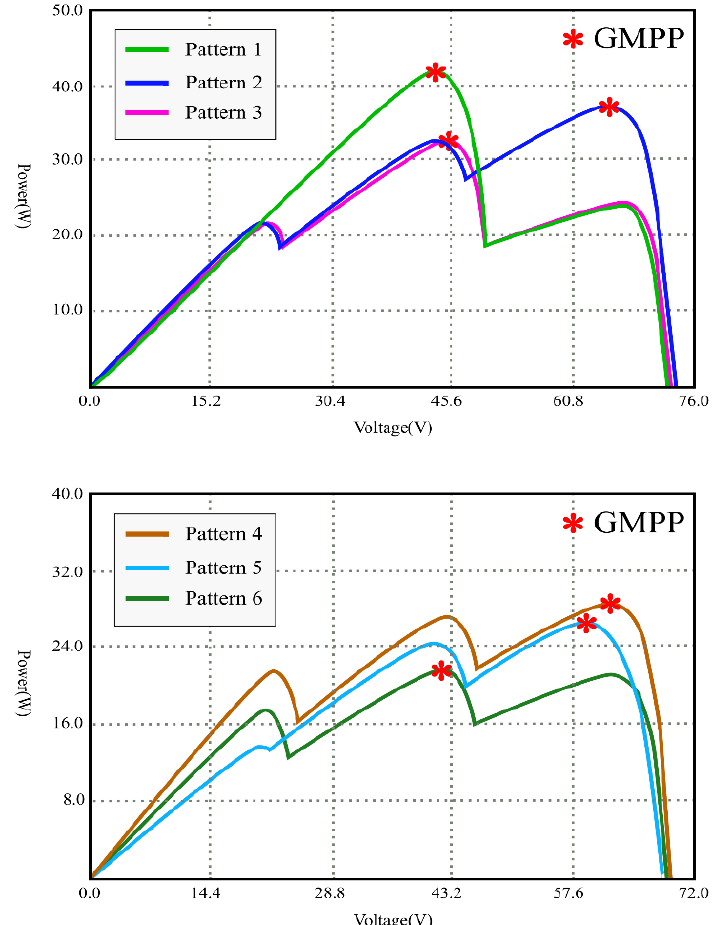
Figure 12. The P-V curves of six test patterns.